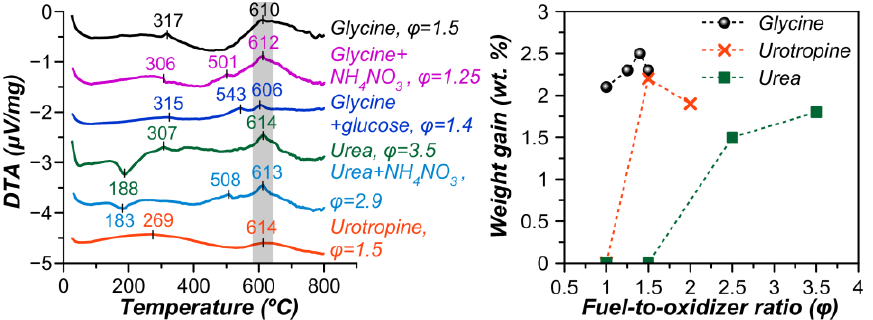
Figure 2. Differential thermal curves and weight gain during heating in air for the as-prepared sam- ples produced by SCS using different fuels, additives, and fuel-to-oxidizer ratios.